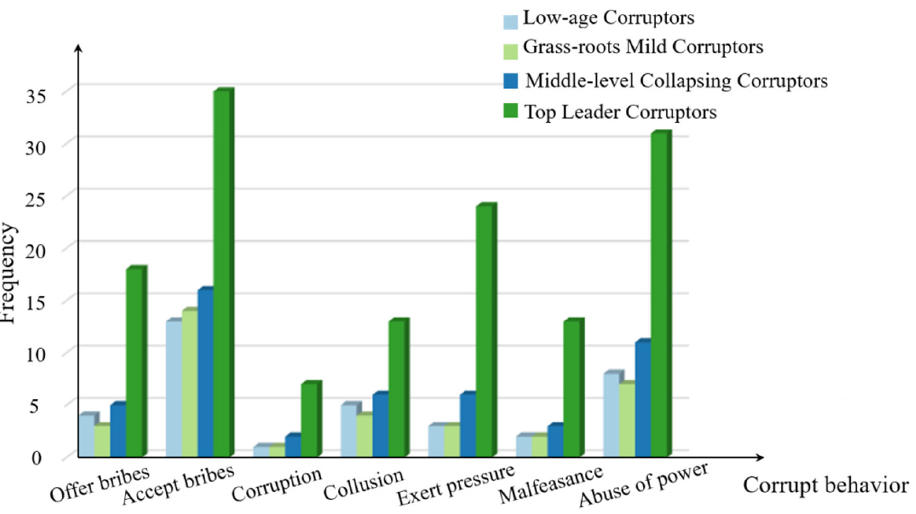
Figure 7. Comparison chart of preference for corrupt behavior.